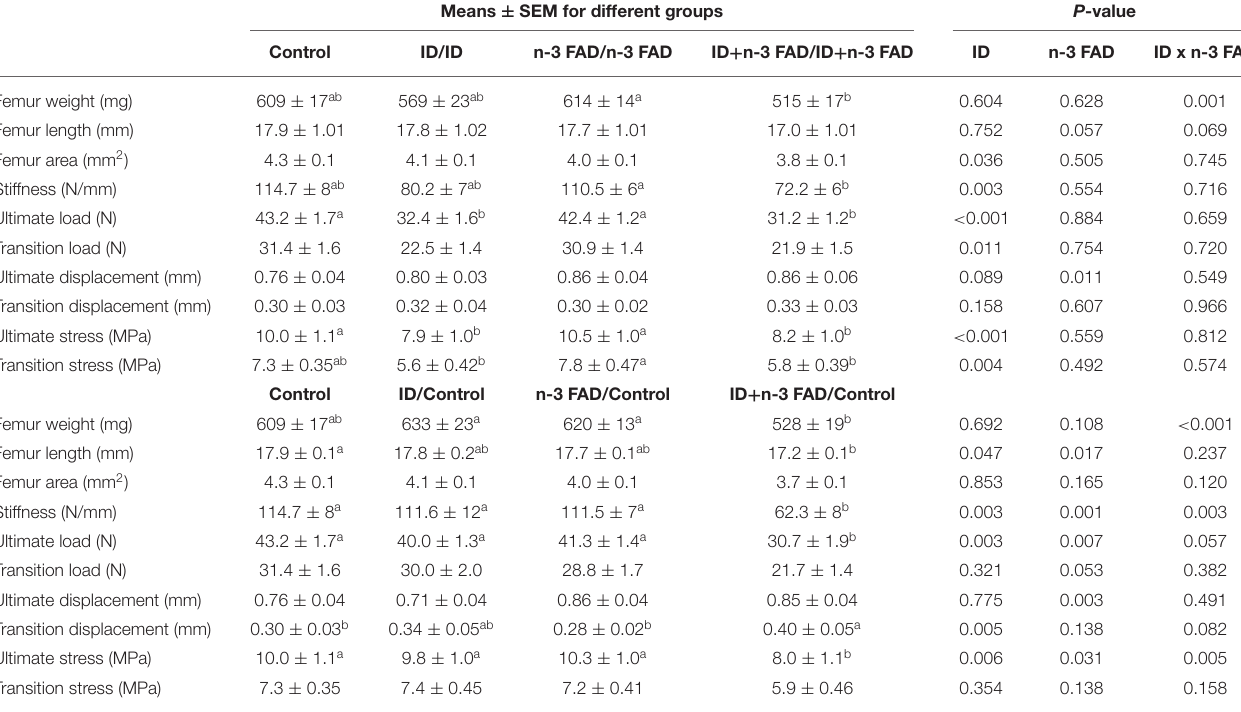
TABLE 2 | Left femur size and bone strength indicators in offspring at post-natal day